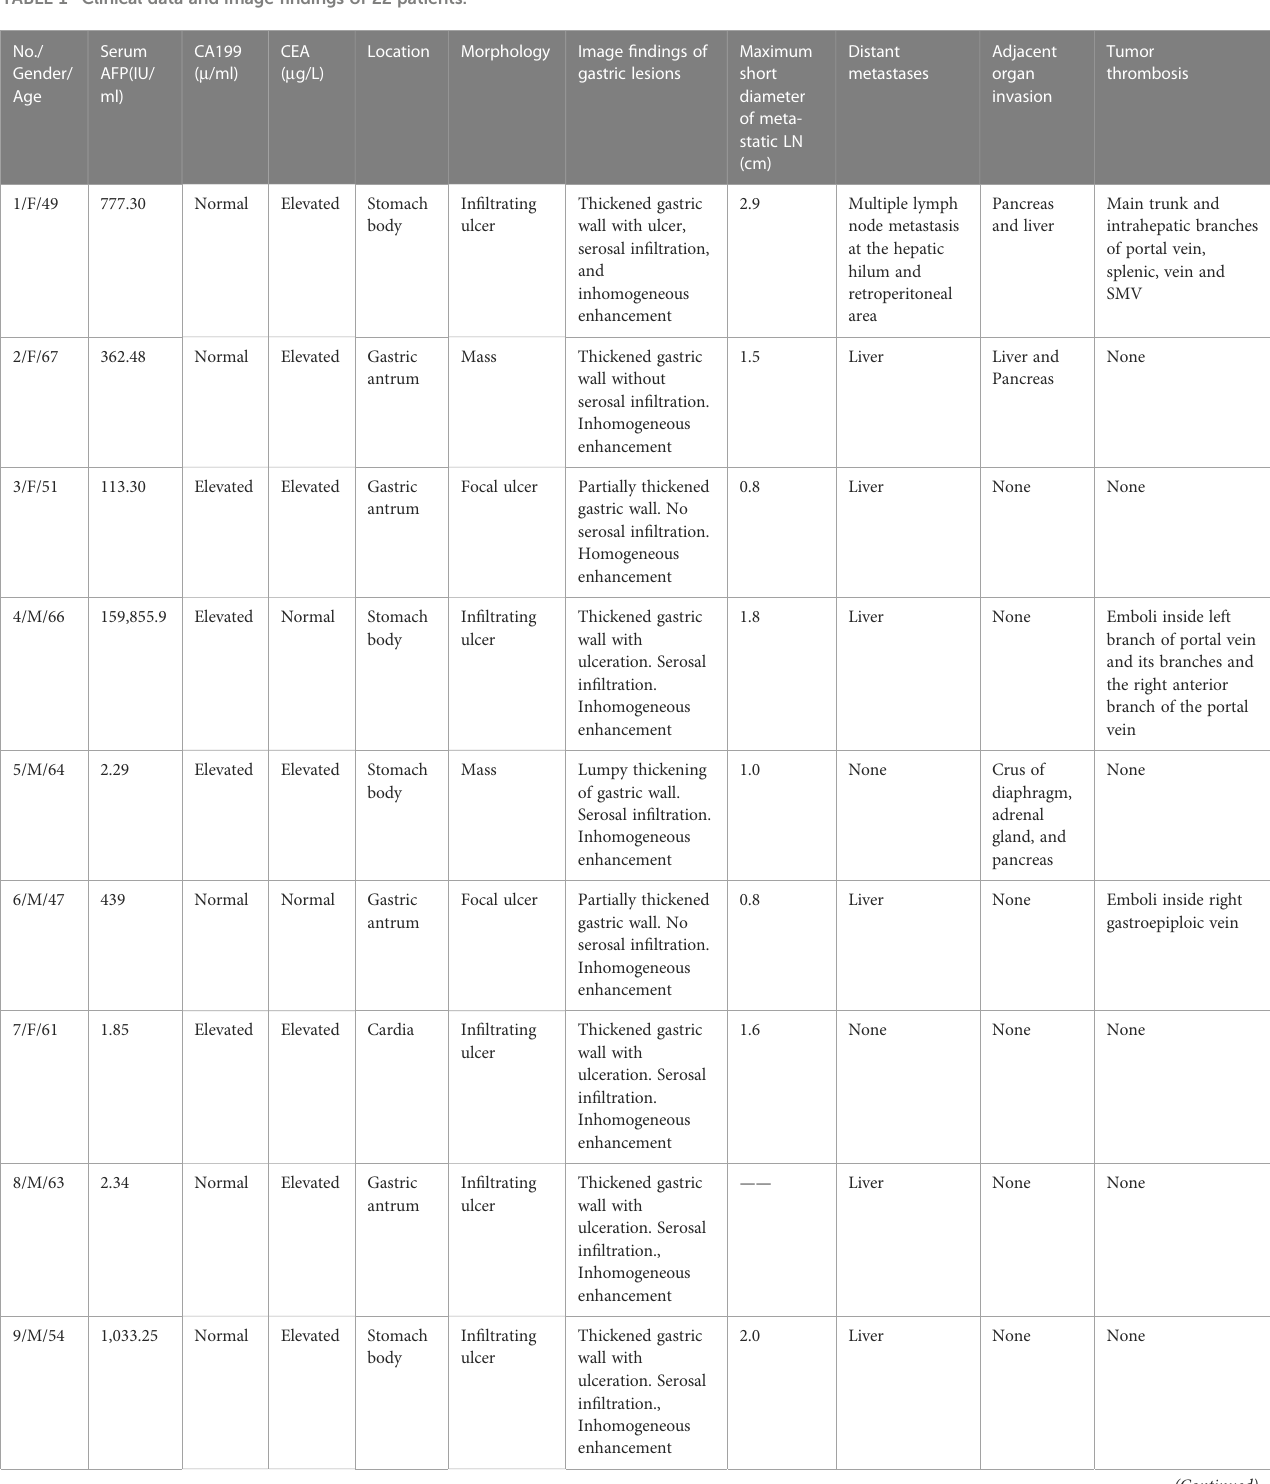
TABLE 1 Clinical data and image fi ndings of 22